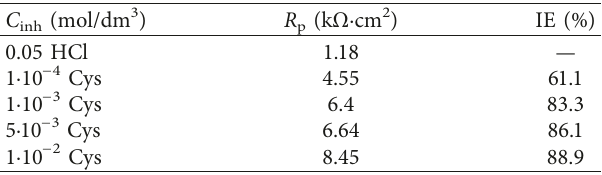
Table 2: Polarization resistance and inhibition efficiency for brass in 0.05M HCl solution with addition of various concentrations of